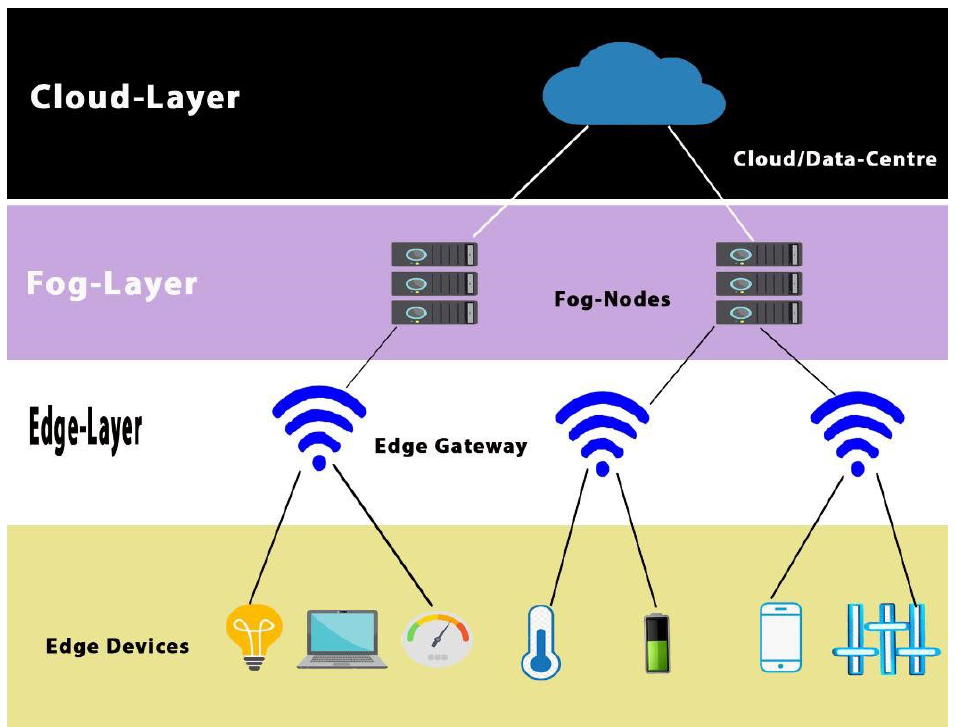
Figure 1. Fog computing architecture-based